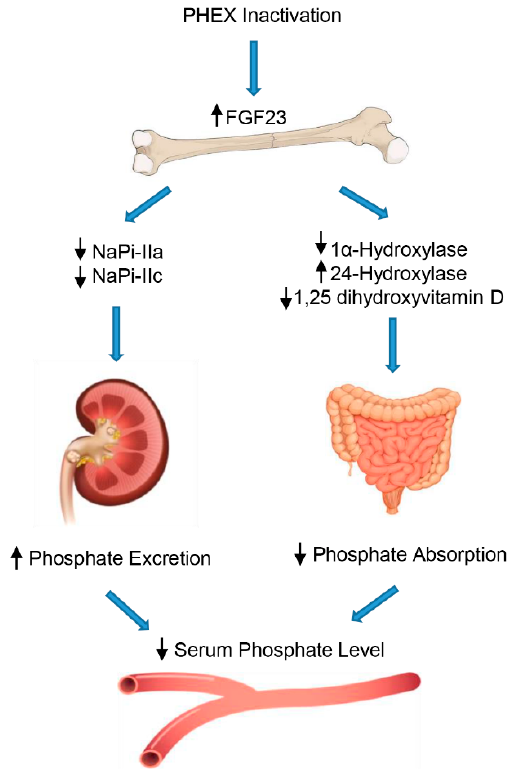
Figure 1. Regulation of phosphate by FGF23. FGF23 decreases the reabsorption of phosphate through regulation of sodium/phosphate cotransporters in the renal proximal tubules. In addition, FGF23 inhibits 1,25-dihydroxyvitamin D production in the proximal renal tubules by downregulat- ing 1 α -hydroxylase (CYP27B1) and upregulating CYP24A1 (24-hydroxylase), leading to decreased phosphate absorption in the intestine.